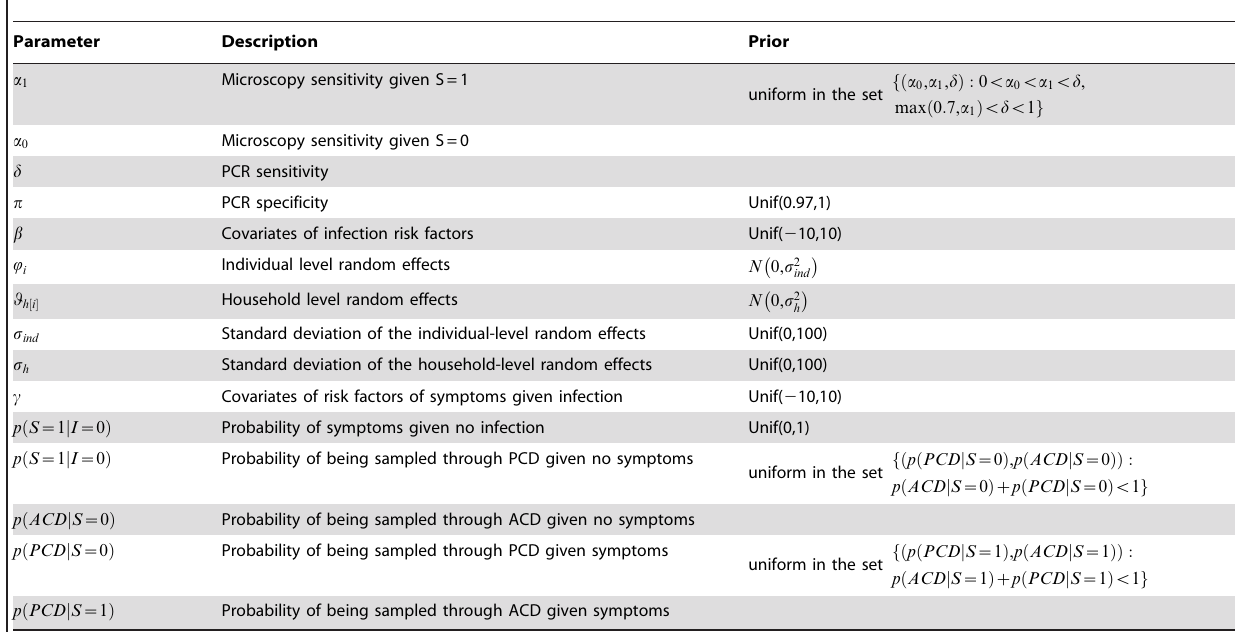
Table 1. List of all the estimated parameters and the associated priors.